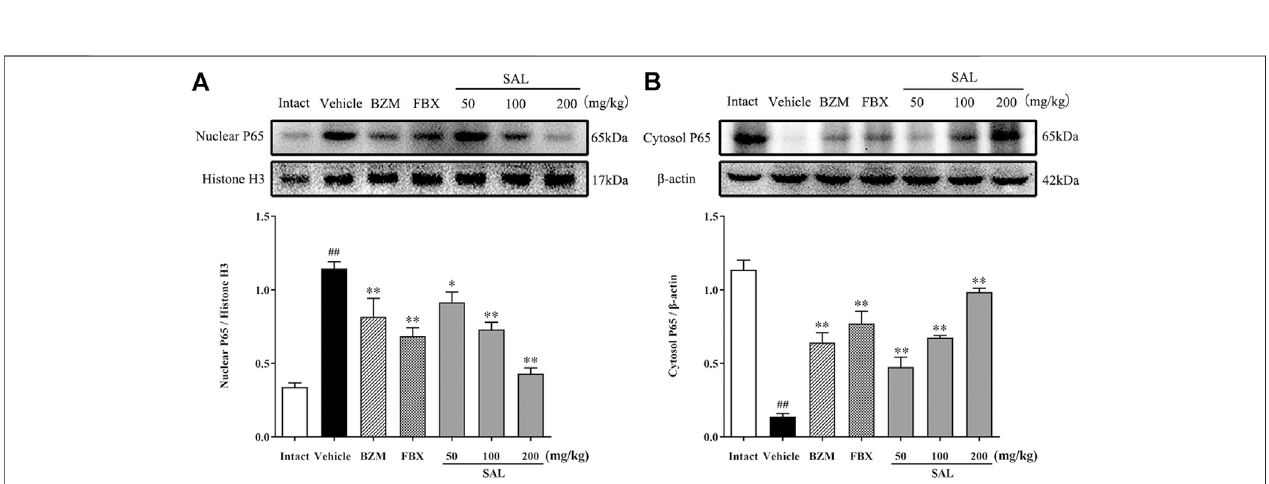
FIGURE 9 | Effects of SAL on the NF- κ B signaling pathway. (A) Cytosol NF- κ B P65; (B) Nuclear NF- κ B P65.